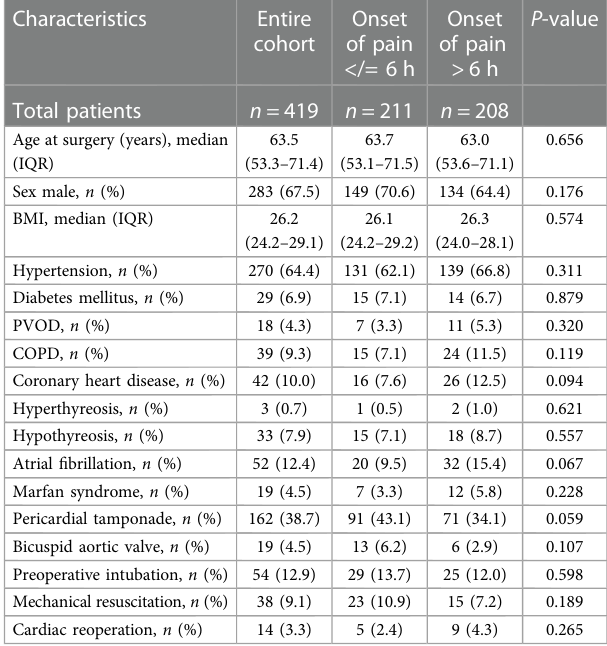
obstructive pulmonary